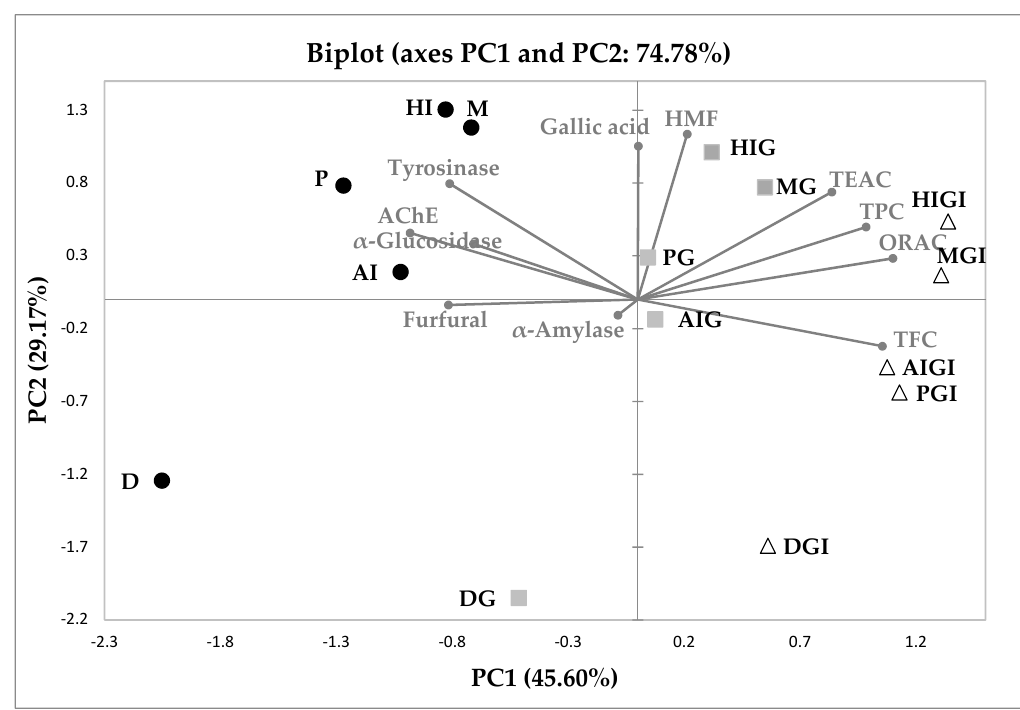
Figure 6. Principal component (PC) analysis plot of gallic acid, furfural, 5-hydroxymethyl furfural (HMF), antioxidant capacity [Trolox Equivalent Antioxidant Capacity (TEAC) and Oxygen Radical Absorption Capacity (ORAC) assays], total phenolic (TPC) and flavonoid (TFC) contents and inhibition of enzymatic ( α -amylase, α -glucosidase, acetylcholinesterase (AChE) and tyrosinase) capacities of carob liqueurs (circles) obtained by aqueous (AI) and hydro-alcoholic (HI) infusions, distillation (D), maceration (M) and percolation (P), and subjected to gastric (squares) and gastrointestinal (triangles) digestions.